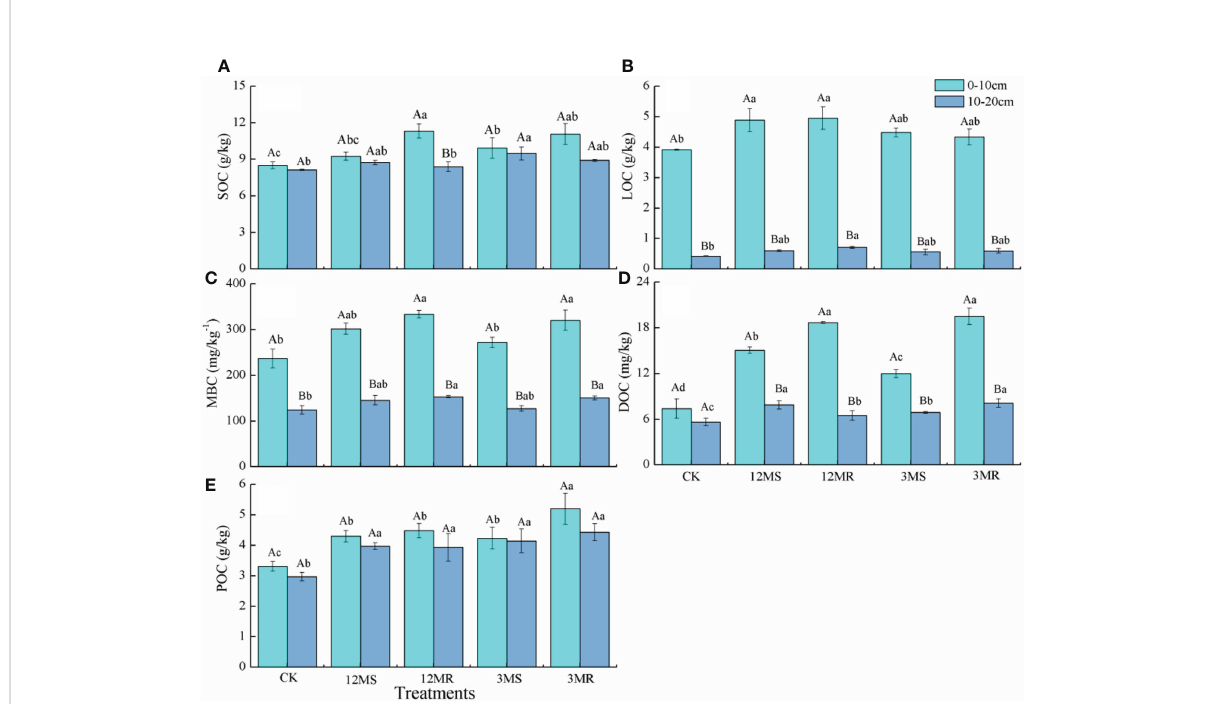
FIGURE 2 Soil organic carbon (SOC, A ), labile organic carbon (LOC, B ), microbial organic carbon (MBC, C ), dissolved organic carbon (DOC, D ), and particulate organic carbon (POC, E ) under different treatments. Data are mean ± SD (n = 4). Different lowercase letters represent signi fi cant differences under different treatments. Different capital letters indicate signi fi cance between 0- to 10-cm and 10- to 20-cm soil layers of each